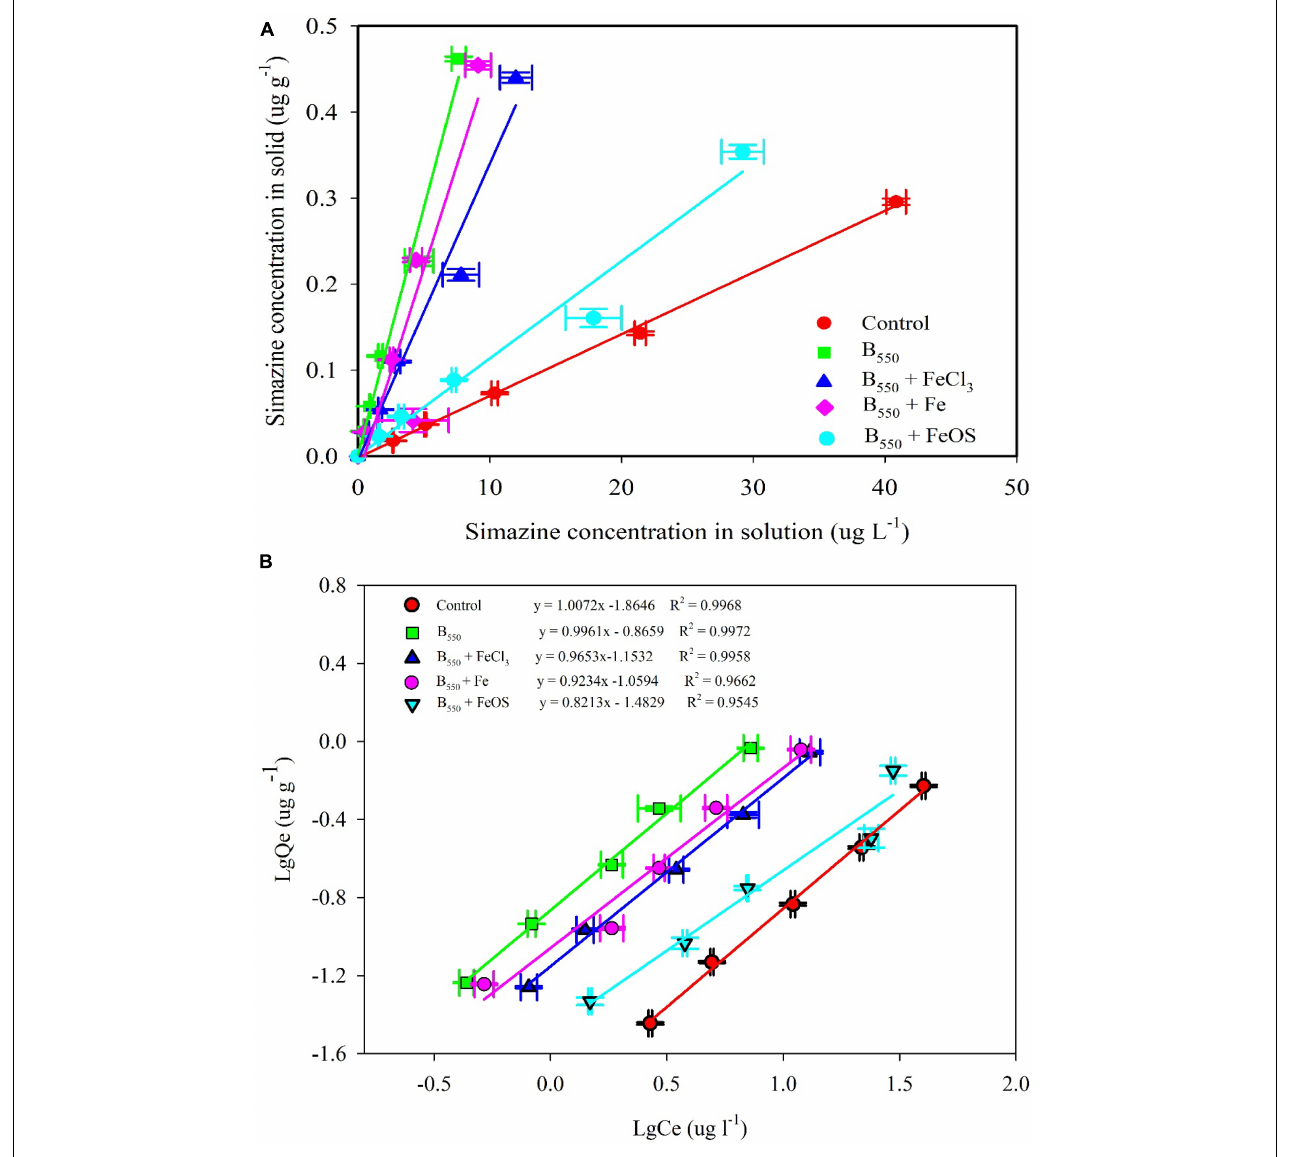
FIGURE 3 | The adsorption of iron modified biochar or pristine biochar on simazine. Distribution of simazine in solid and liquid phases (A) and Freundlich isotherms (B)